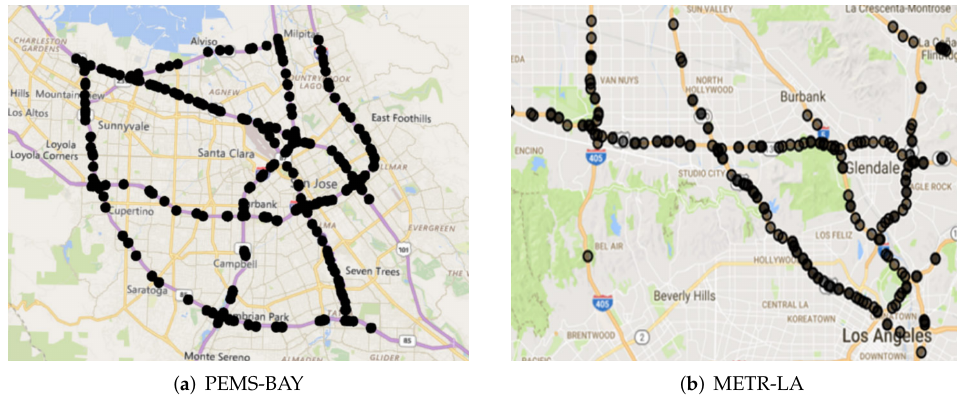
Figure 6. Monitor distribution in PEMS-BAY and METR-LA dataset